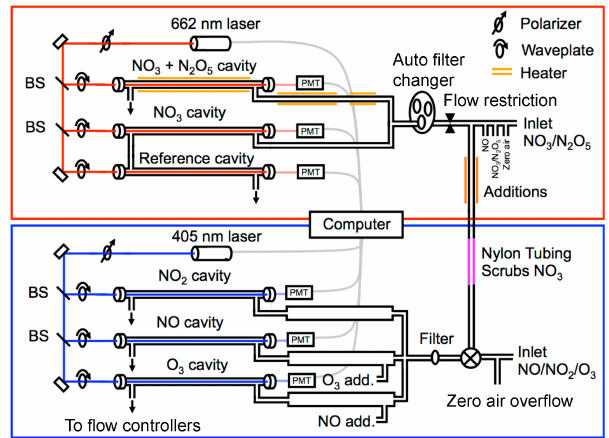
Figure A6. Schematics of the nitrogen oxide CRDS